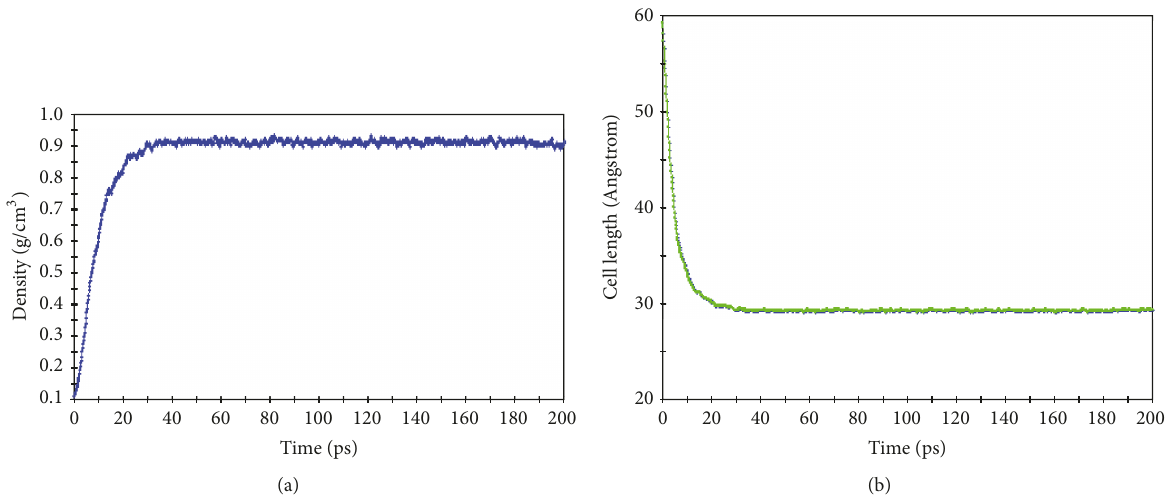
Figure 7: Change of (a) system density and (b) system length of side with time at 0.08